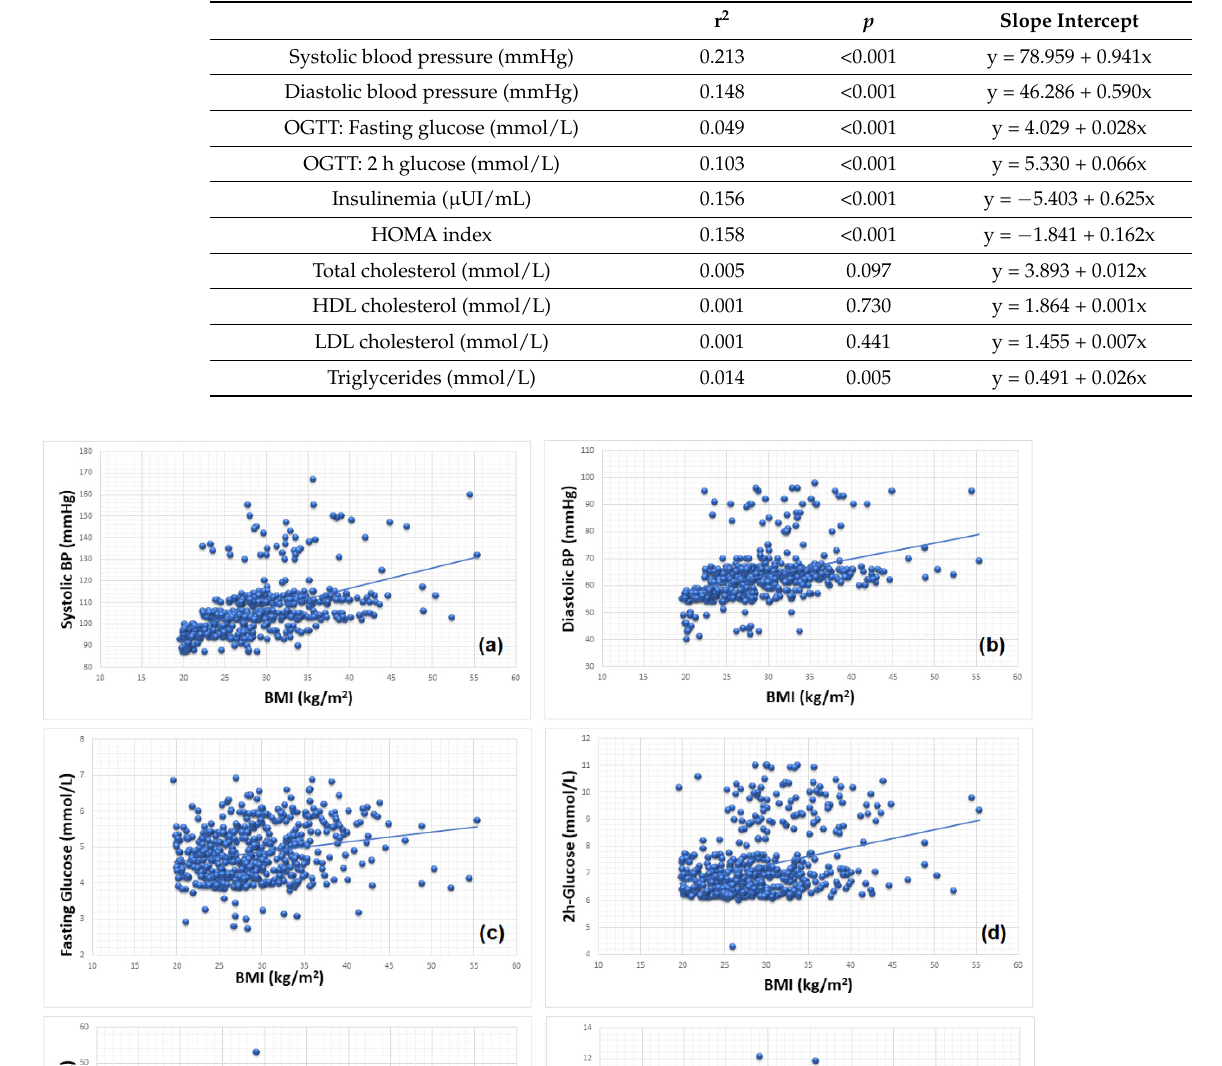
Table 4. Regression analysis versus BMI.